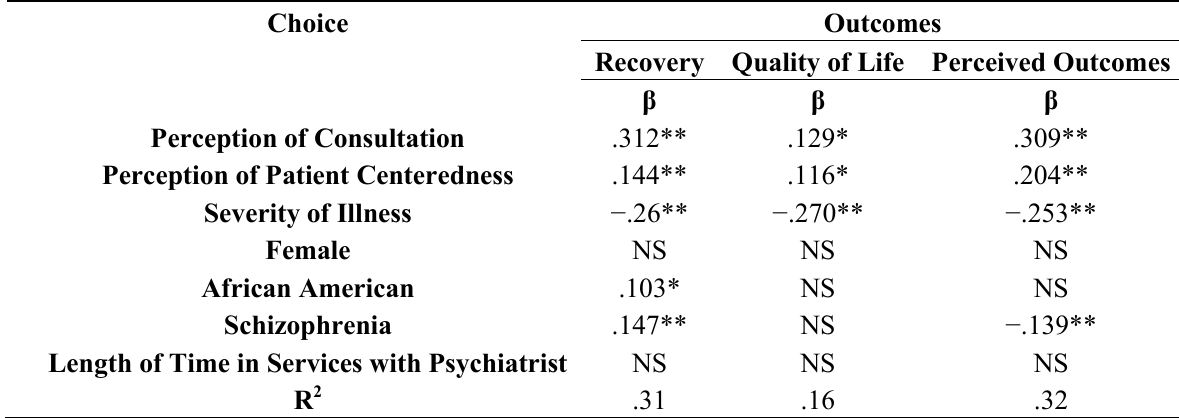
Table 2. Regression analyses examining the relationship between choice and outcomes.